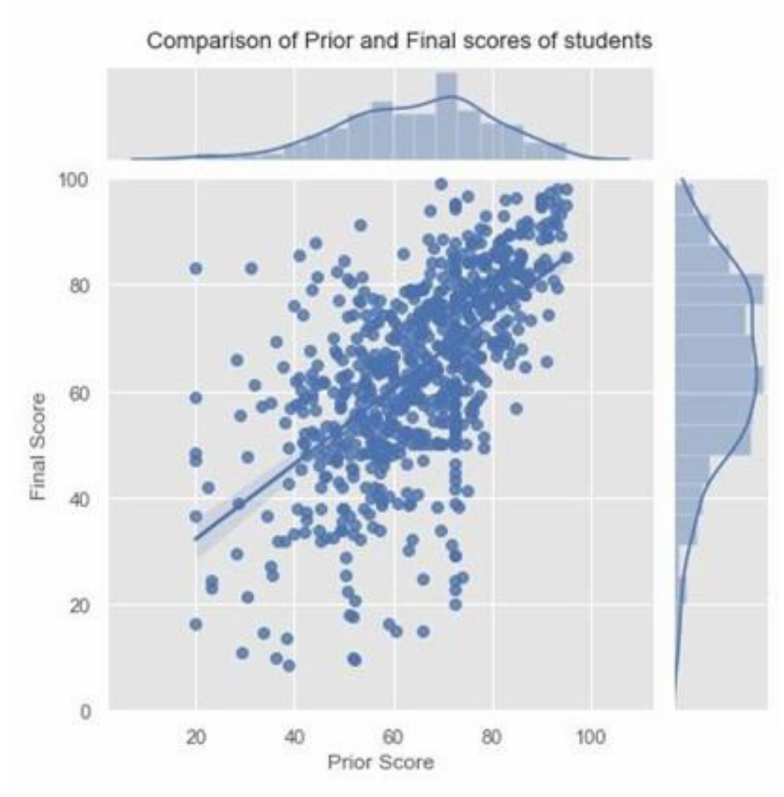
Figure 1. Comparison of prior score with final score of